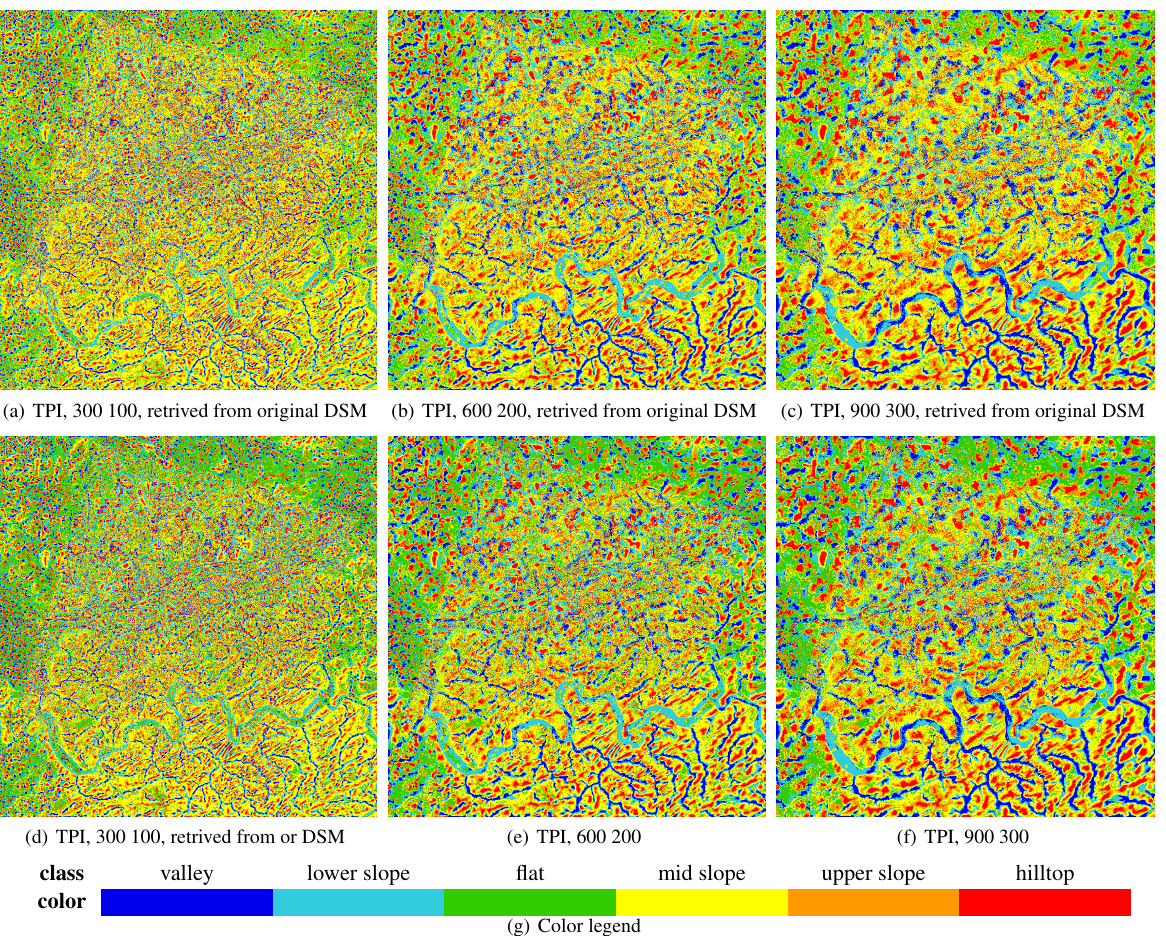
Figure 4: Comparison classification results for different kernel masks and spatial resolutions of